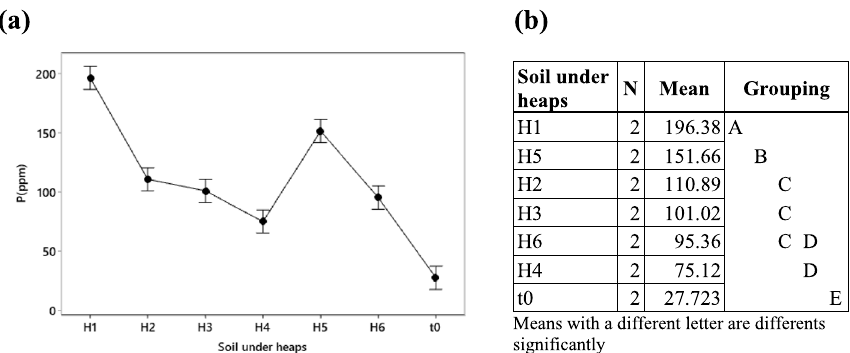
Fig. 5 Statistical tests related to P content under the soil (p<0.05) : a confidence intervals related to P means under the soil before ( t 0 ) and after composting (under H1 to H6) ( one-way ANOVA test ); b Tukey test